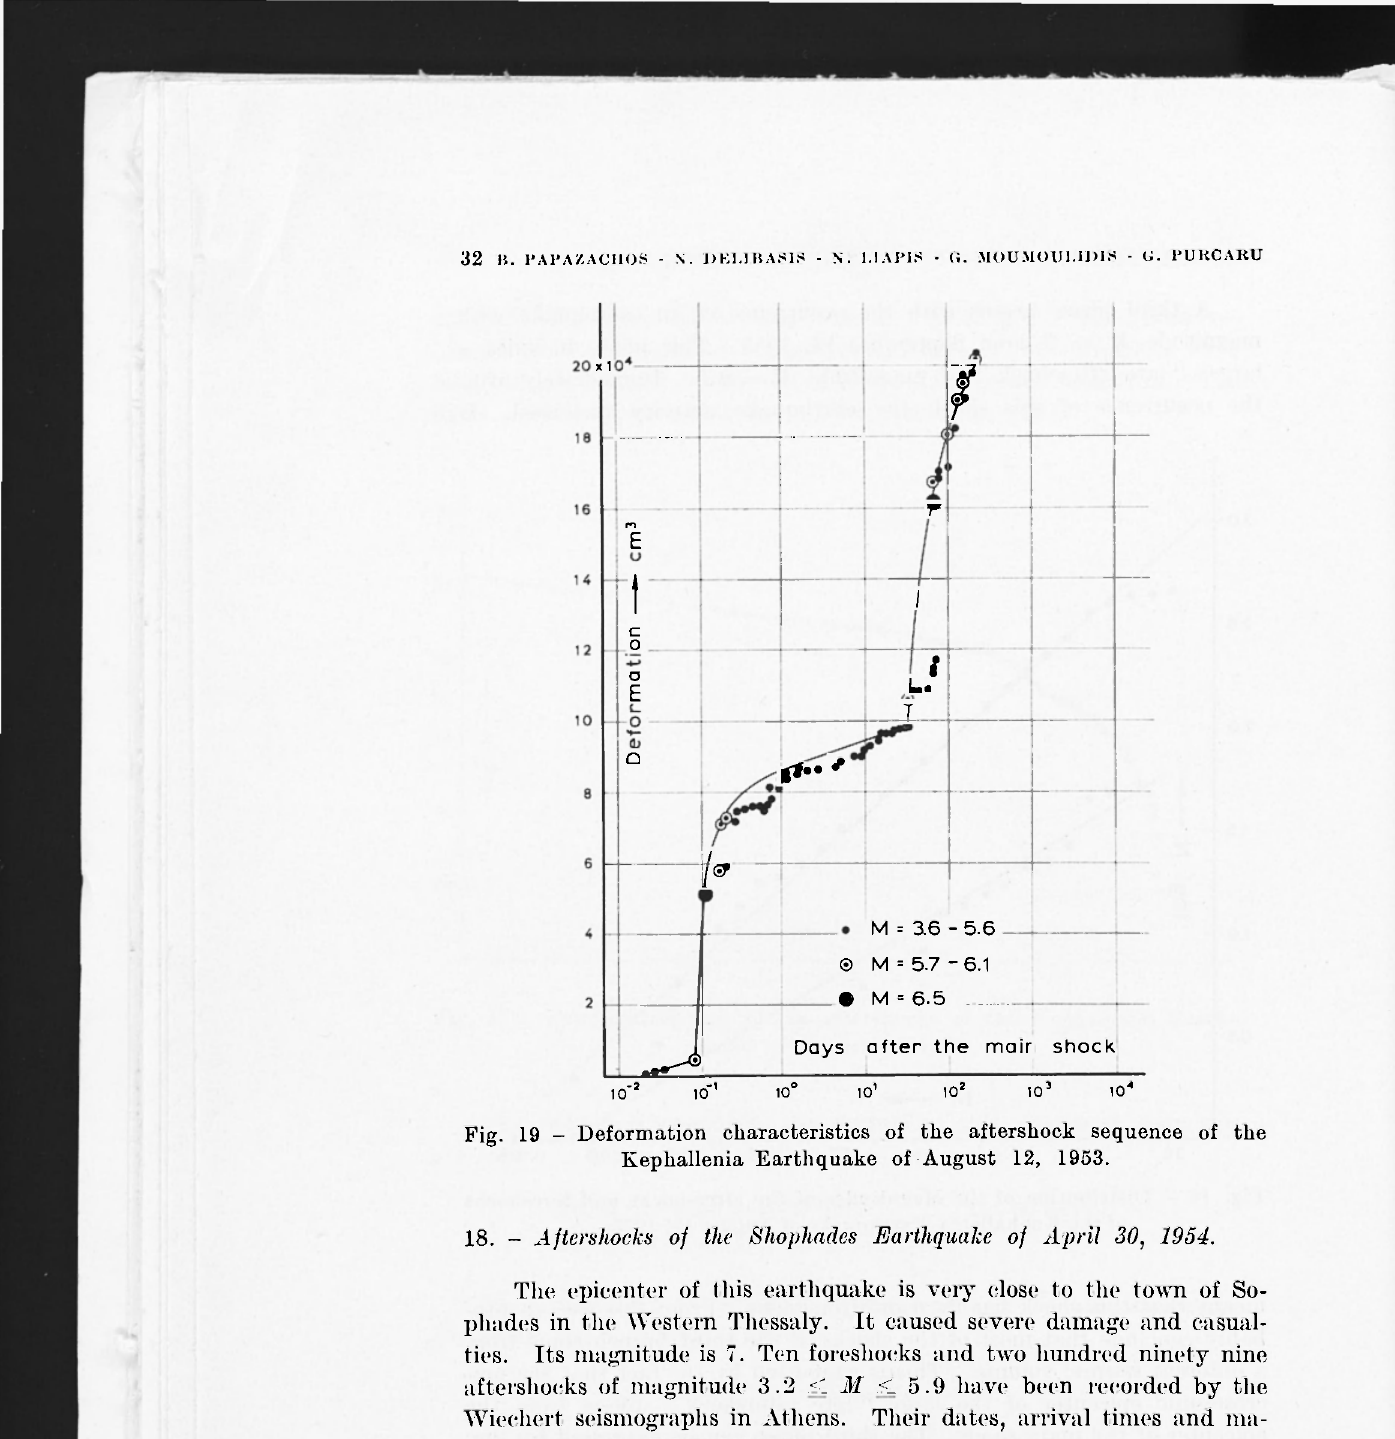
Fig. 19 - Deformation characteristics of the aftershock sequence of the Kephallenia Earthquake of August 12,